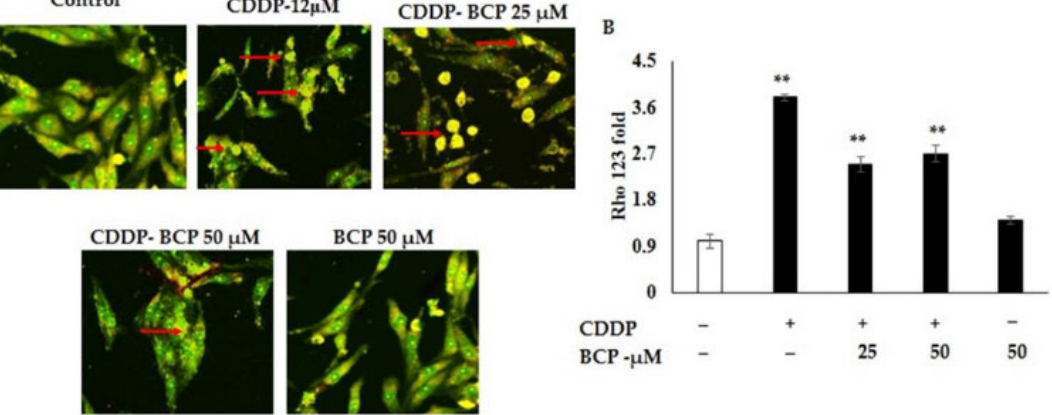
Figure 3. BCP abrogates metabolic activity of A549 lung cancer cells. Rhodamine 123 staining explores the mitochondrial membrane potential of cancer cells. ( A , B ) A549 cells were grown on a cover slip-pasted 12-well plate and exposed to CDDP and BCP (12 and 25 µ M) alone or in combination and treated for 12 h. ( A ) Cells were incubated with methanol fixed Rho-123 and quantified the excited illumination using fluorescent microscope (Leica). ( B ) The mitochondrial damage and the membrane integrity are shown; less damage and high integrity (green color), more release of content and less integrity (yellow color, arrows), 20× magnification. Values shown are mean ± SD for three independent experiments. ** p < 0.01 high significant differences, respectively, relative to DMSO- treated cell lines.